Question: Which kind of chart has been used to present this data?
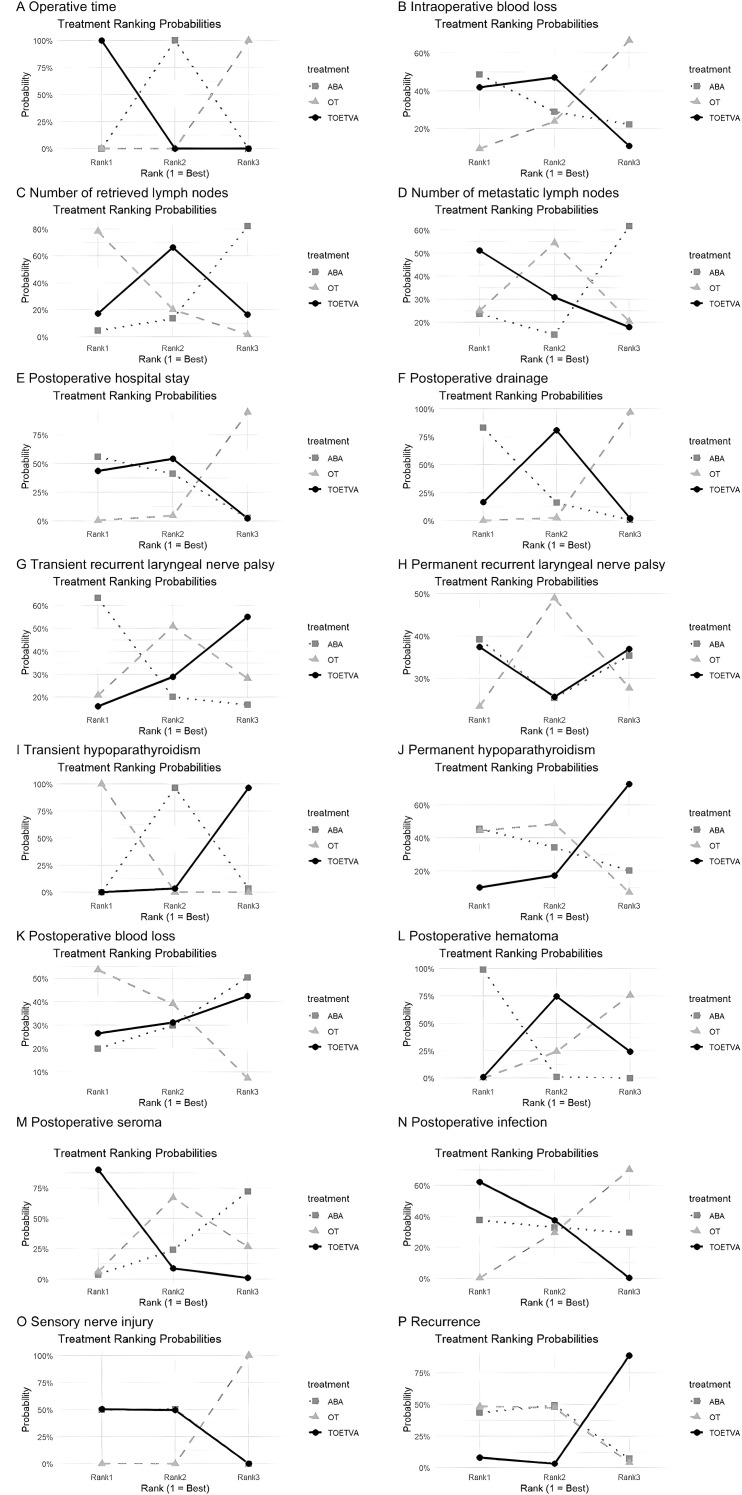
Answer: line